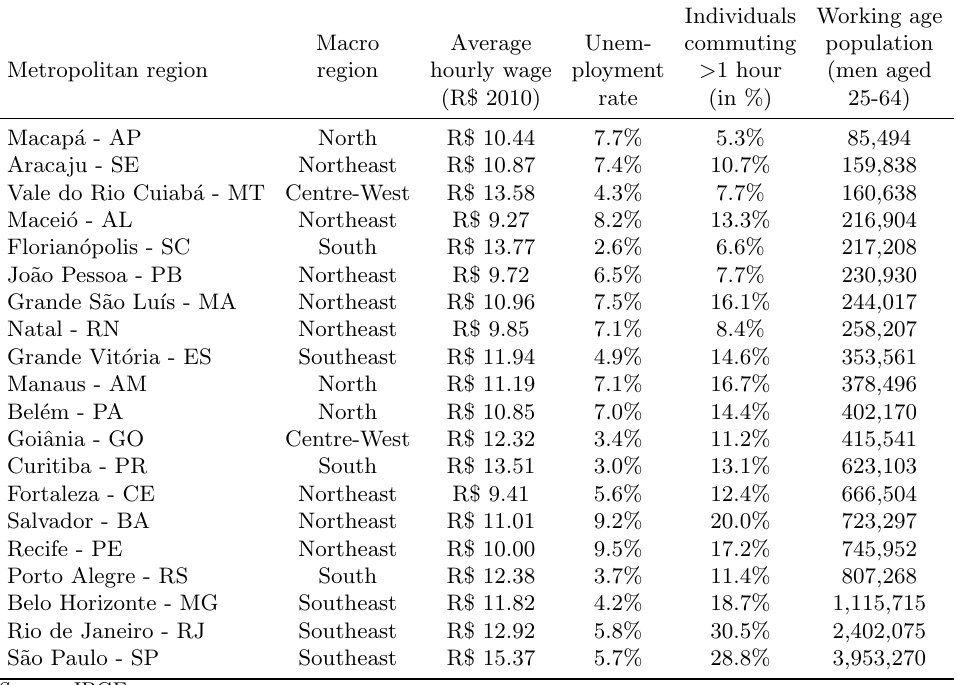
Table 1: Descriptive characteristics of each metropolitan area (ordered by the size of working age population),